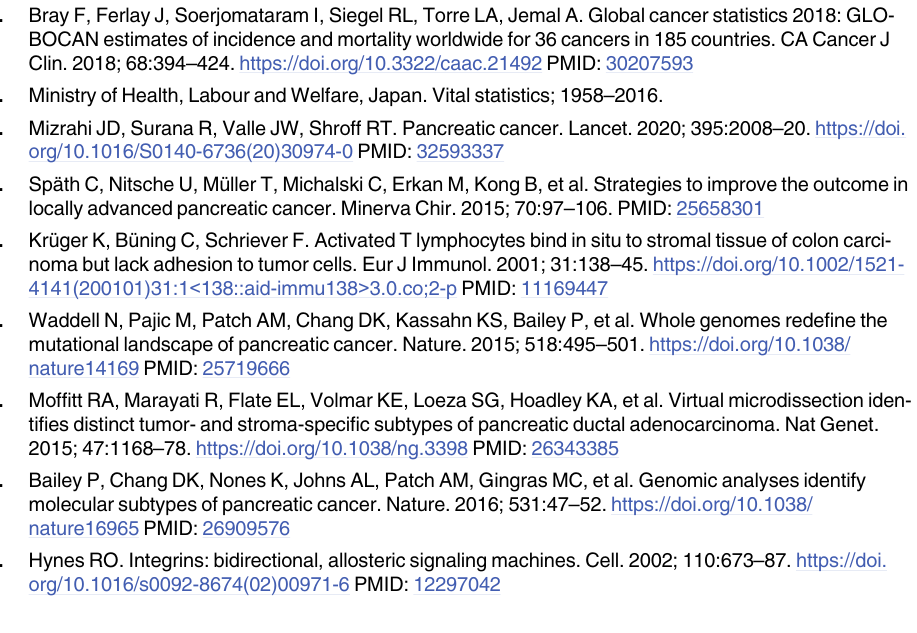
S1 Fig. Heatmap for 314 DEGs. Genes with differential expression between the PDAC tissue and its adjacent pancreatic tissue were mapped and visualized on a heat map. S1 Table. Results for KEGG pathway analysis. KEGG pathway analysis was performed on 314 DEGs, and a P value of 0.01 or less was considered significant, and 20 pathways were